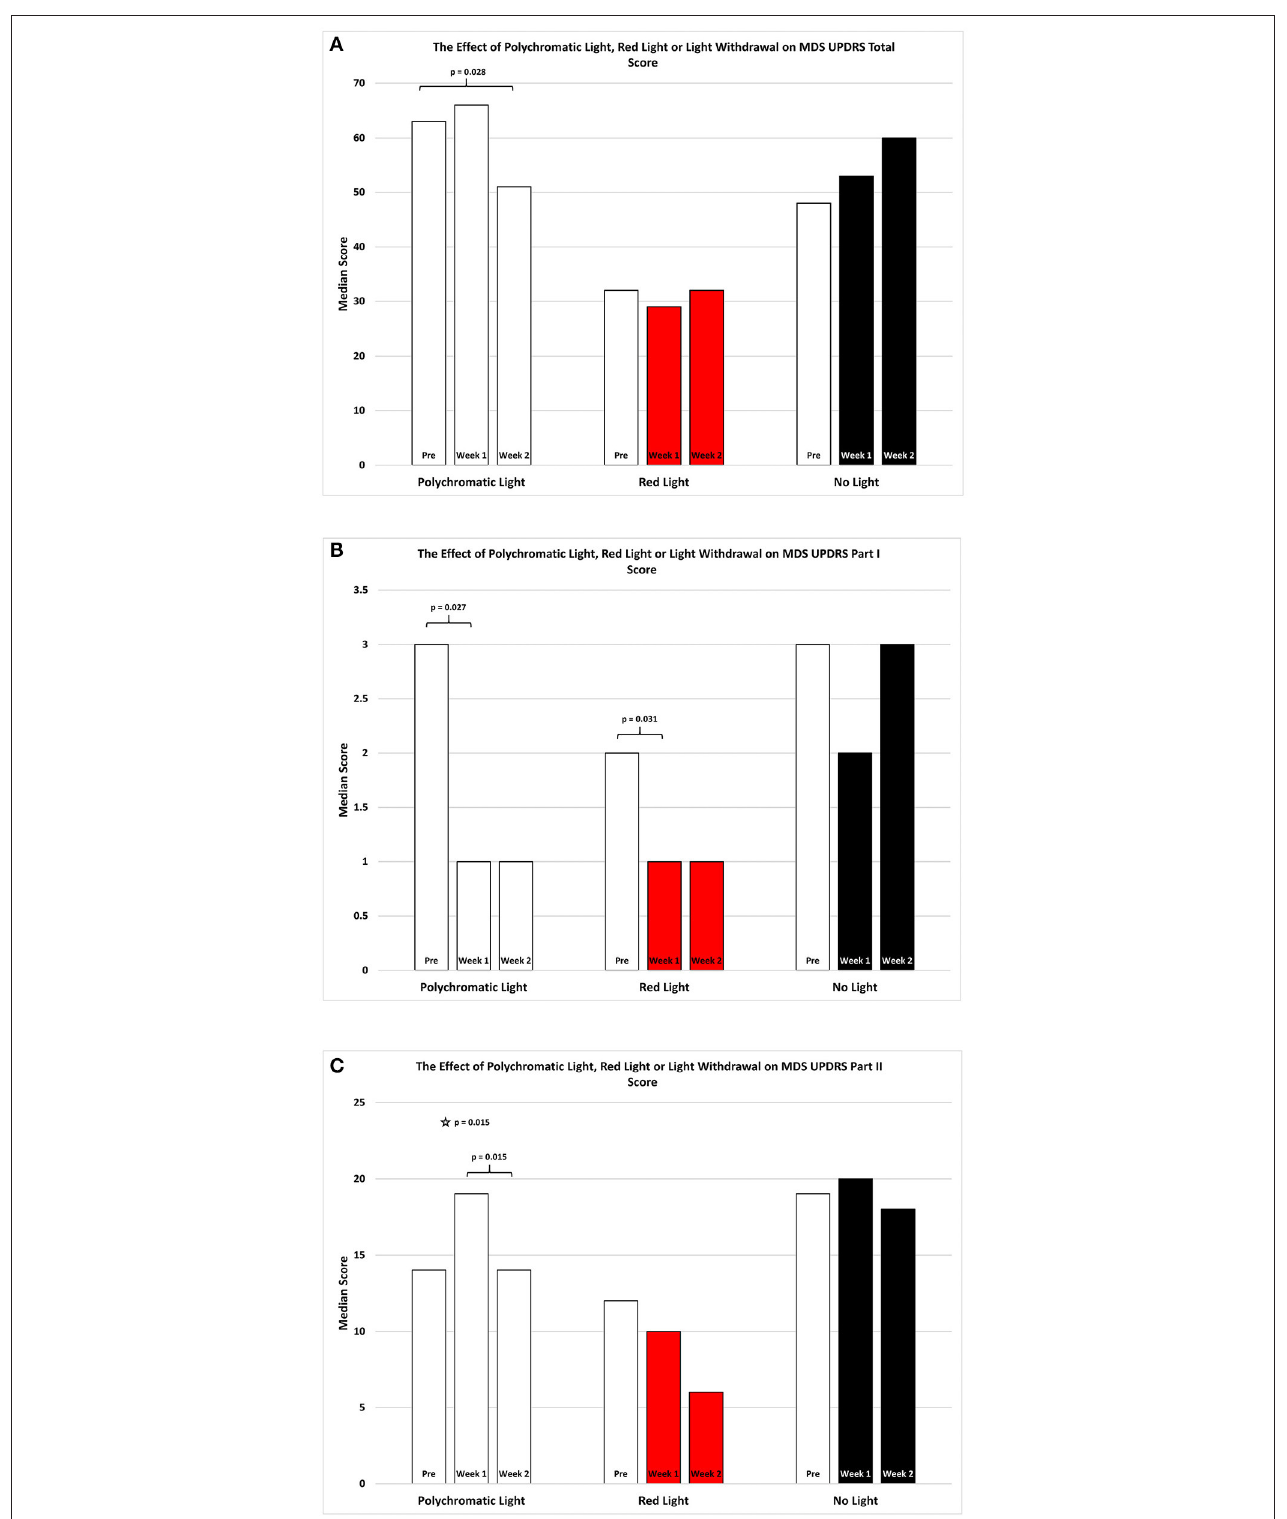
FIGURE 1 | The effect of continued daily exposure to polychromatic light, red light or withdrawal of polychromatic light on M.D.S.U.P.D.R.S. scores in patients treated previously with BT. Performance on the Total Score (A) , Part I (B) and Part II (C) is expressed as the median score for each group after 3 assessments over a 2